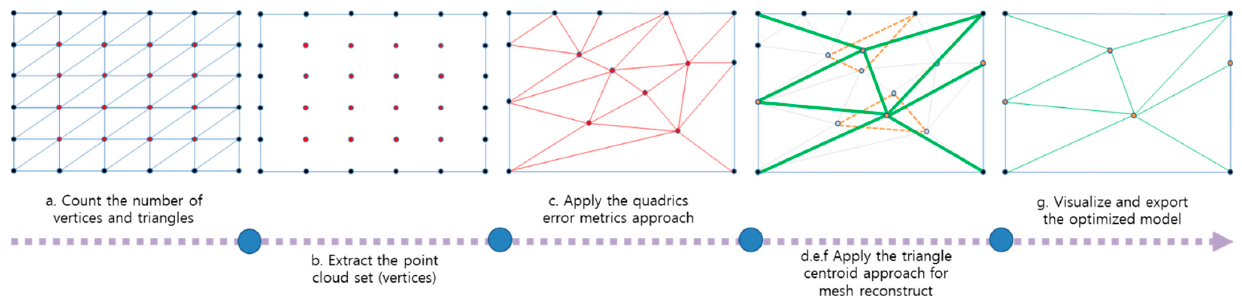
Figure 4. Illustration of algorithm steps.